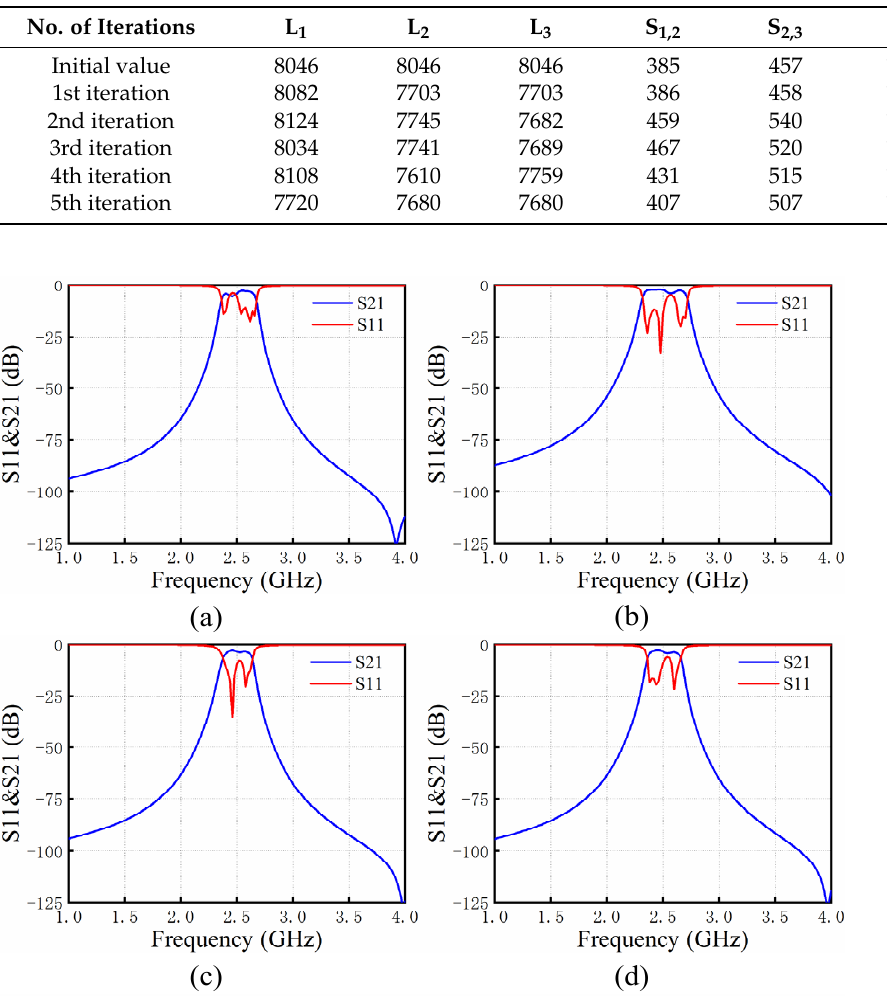
(f) Figure 6. ( a ) Initial response of the filter. ( b ) Response after the first iteration. ( c ) Response after the second iteration. ( d ) Response after the fourth iteration. ( e ) Response after the fifth iteration. ( f ) Response after the sixth iteration. The optimized parameters of the filter after each iteration are shown in Table 1. Table 1. The optimization parameter in each iteration (unit: µm). No. of